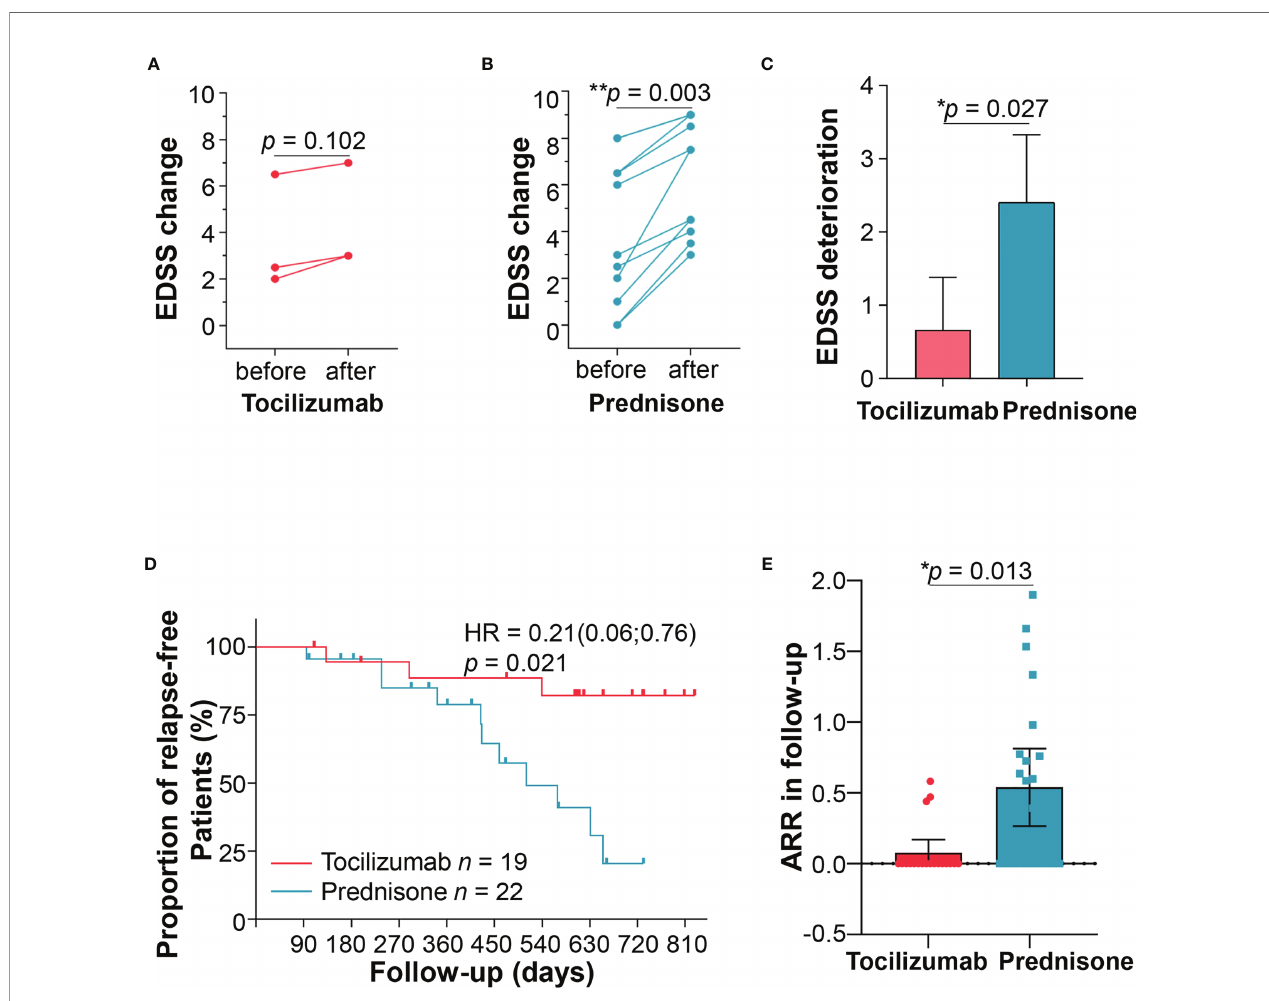
FIGURE 6 | Patient relapses. Three patients relapsed in the tocilizumab group, and expanded disability status scale (EDSS) scores were compared before and after the relapse. (B) Eleven patients relapsed in the prednisone group, and EDSS scores were compared before and after the relapse. (C) Comparisons of EDSS changes between the two groups. (D) Kaplan – Meier curve estimating the proportion of patients who experienced no relapses during two years of follow-up in the two groups. (E) ARR after tocilizumab or prednisone treatment during follow-ups. ARR, annualized relapse